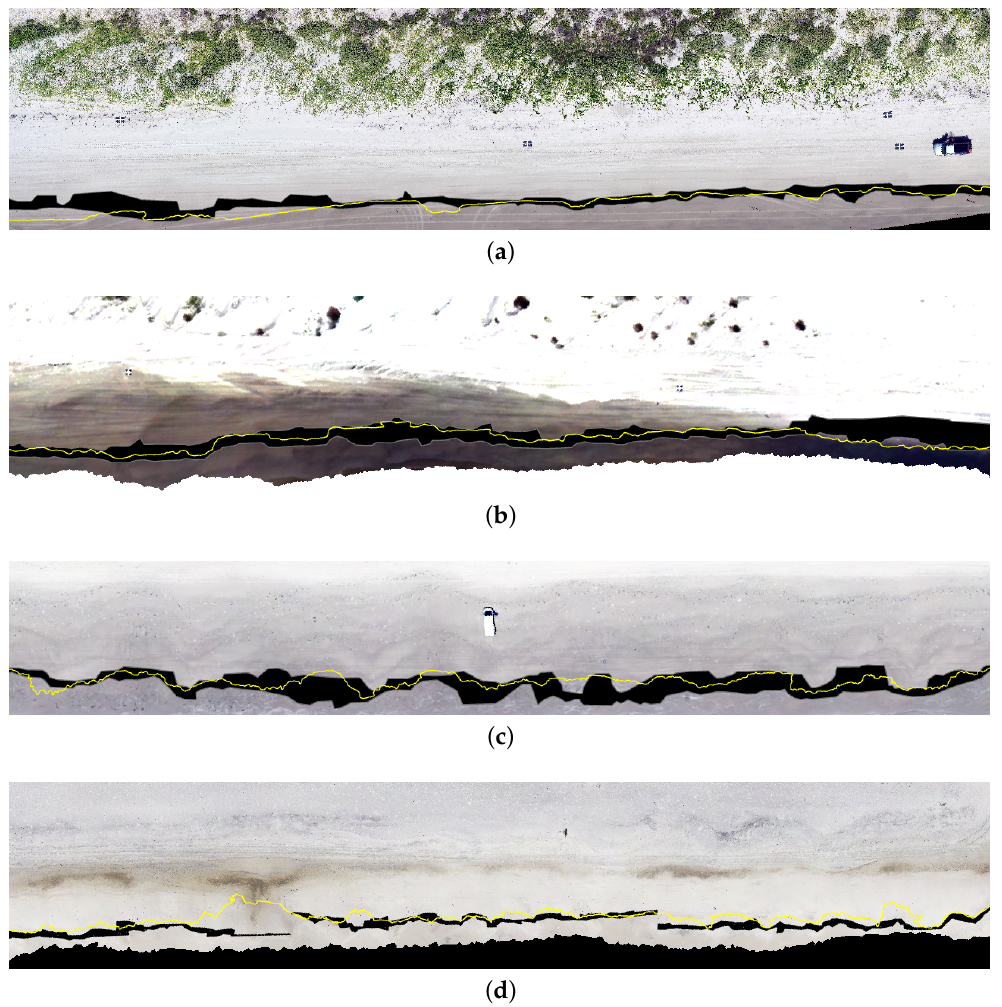
Figure 9. ( a ) Flight 4, ( b ) Flight 6, ( c ) Flight 7, ( d ) Flight 9. The yellow line is the labeled wet/dry shoreline, while the black area is the predicted AI wet/dry